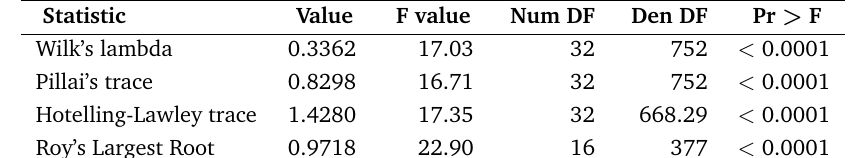
Table 10. Values and significant levels of different statistical tests. DF, degrees of freedom.